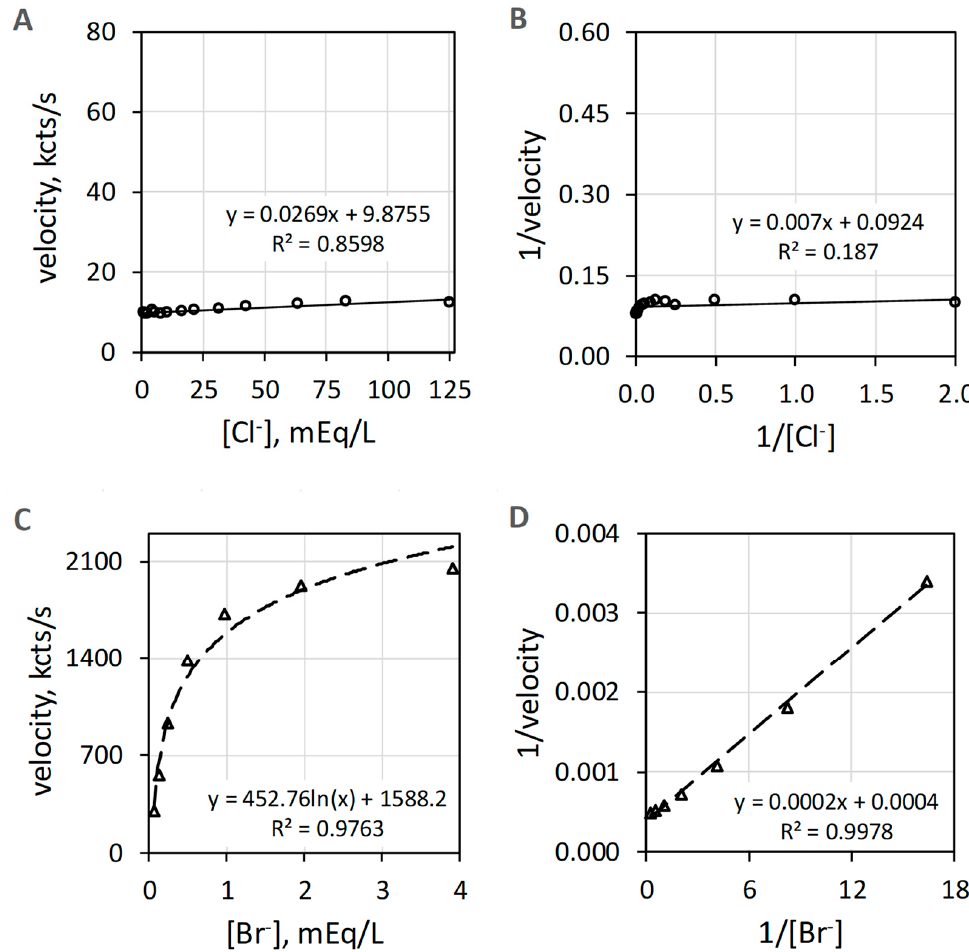
Figure 4. Plots of EPO catalyzed luminol luminescence against halide concentration. ( A ) shows very low velocity to all [Cl − ] (mEq/L) tested. ( B ) shows the double reciprocal plot of 1/velocity (1/(kcts/s)) against 1/[Cl − ] (1/(mEq/L)) with a coefficient of determination (R 2 ) of 0.19. ( C ) depicts the hyperbolic response to increasing [Br − ] (mEq/L). ( D ) shows the double reciprocal plot of 1/velocity (1/(kcts/s)) against 1/[Br − ] (1/(mEq/L)) showing proper linearity. Cl − and Br − concentrations were varied using a constant concentration of 39 nM EPO, 51 µM luminol, and 6.3 mM H 2 O 2 in 50 mM acetate buffer pH 5. Reaction was initiated by mixing of reactants. The final volume was 1.0 mL. Background lumi- nescence in the absence of enzyme is about 1.5 kcts/s.